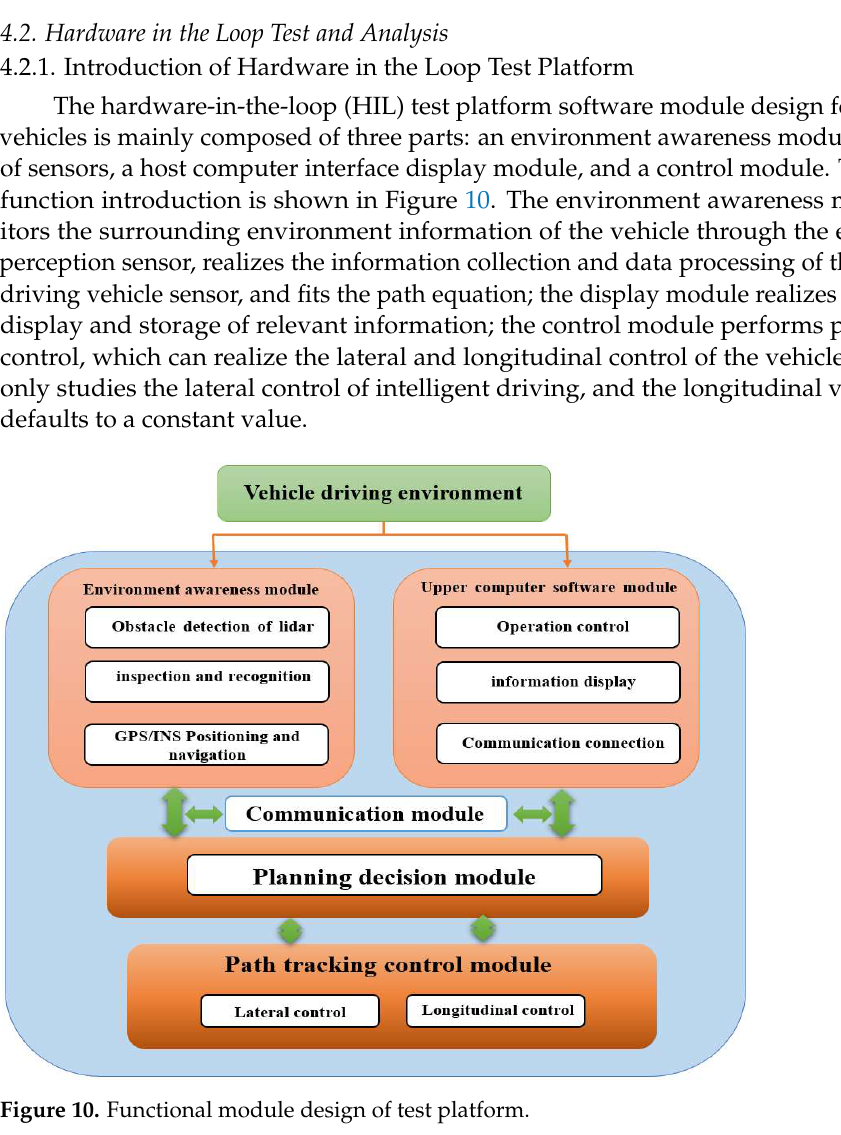
Figure 9. Test results under complex steering conditions.